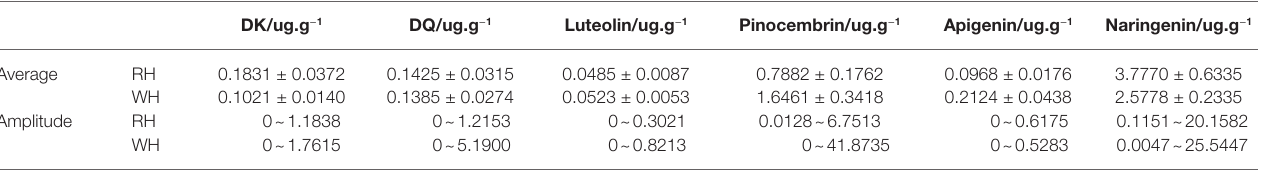
TABLE 2 | Differences in the content of secondary metabolites in the heartwood of red- and white-heart Chinese fir. DK/ug.g −